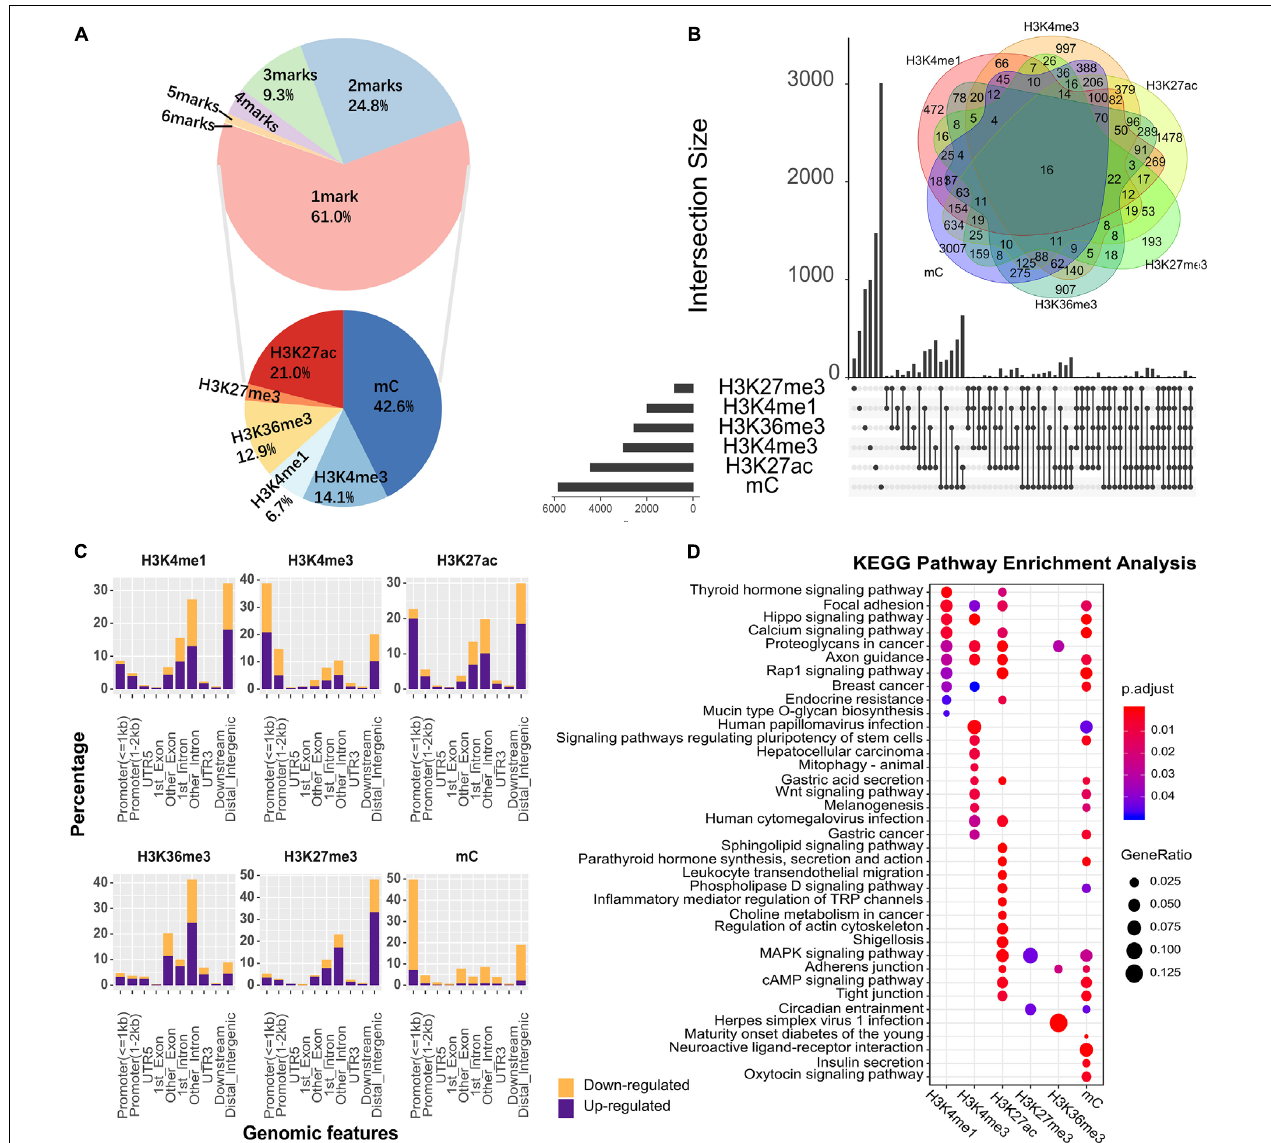
FIGURE 1 | The epigenetic alteration for different genomic features in GC. (A) The proportion of genomic regions occupied by different numbers of epigenetic alterations. In the upper pie chart, 61% of genomic region were occupied by 1 epigenetic mark, and the remaining regions were co-occupied by varying numbers of epigenetic marks. Base on the genomic region occupied by 1 mark, the lower pie chart showed the proportion of genomic regions occupied by different types of epigenetic marks. (B) Overview of co-localization for each epigenetic modification. The intersection area indicates the count of co-altered epigenetic modifications, corresponding to the number in the Venn diagram. Different types of epigenetic marks altered together were connected by black lines. (C) The percentage of genomic features with altered epigenetic modifications. Upregulated and downregulated epigenetic modifications were colored in purple and orange, respectively. (D) KEGG enrichment analysis for all DHMRs. The X -axis denotes different types of epigenetic